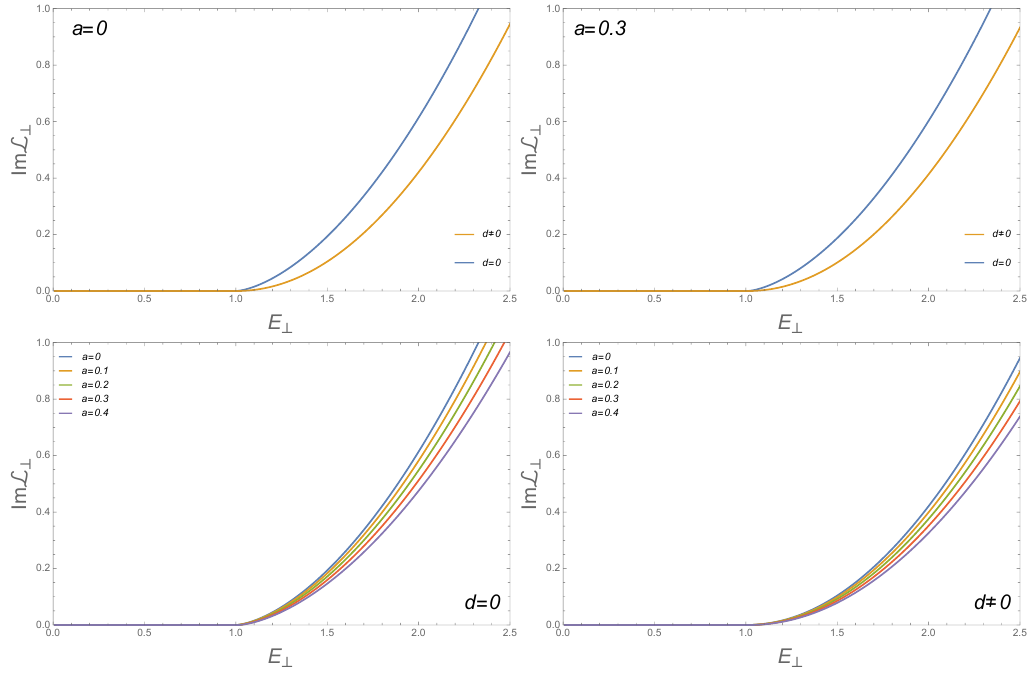
Figure 12 . The imaginary part of the Lagrangian L in the bubble brane background.